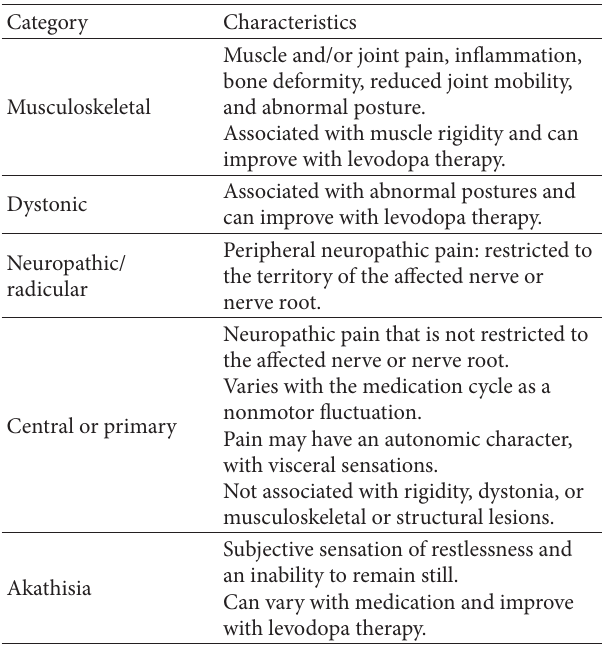
Table 1: Classification of pain related to Parkinson’s